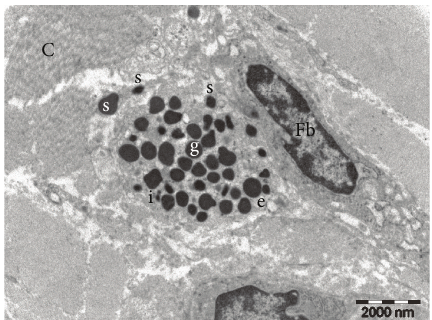
Figure 5: Electron microscopy picture from Stress 1 day rat group. Mast cell with dense granules (g), granules emptied of content (e), granules showing altered electron densities (i), and granules on the verge of releasing the content into the extracellular space (s). Collagen (C) and fibroblast (Fb).